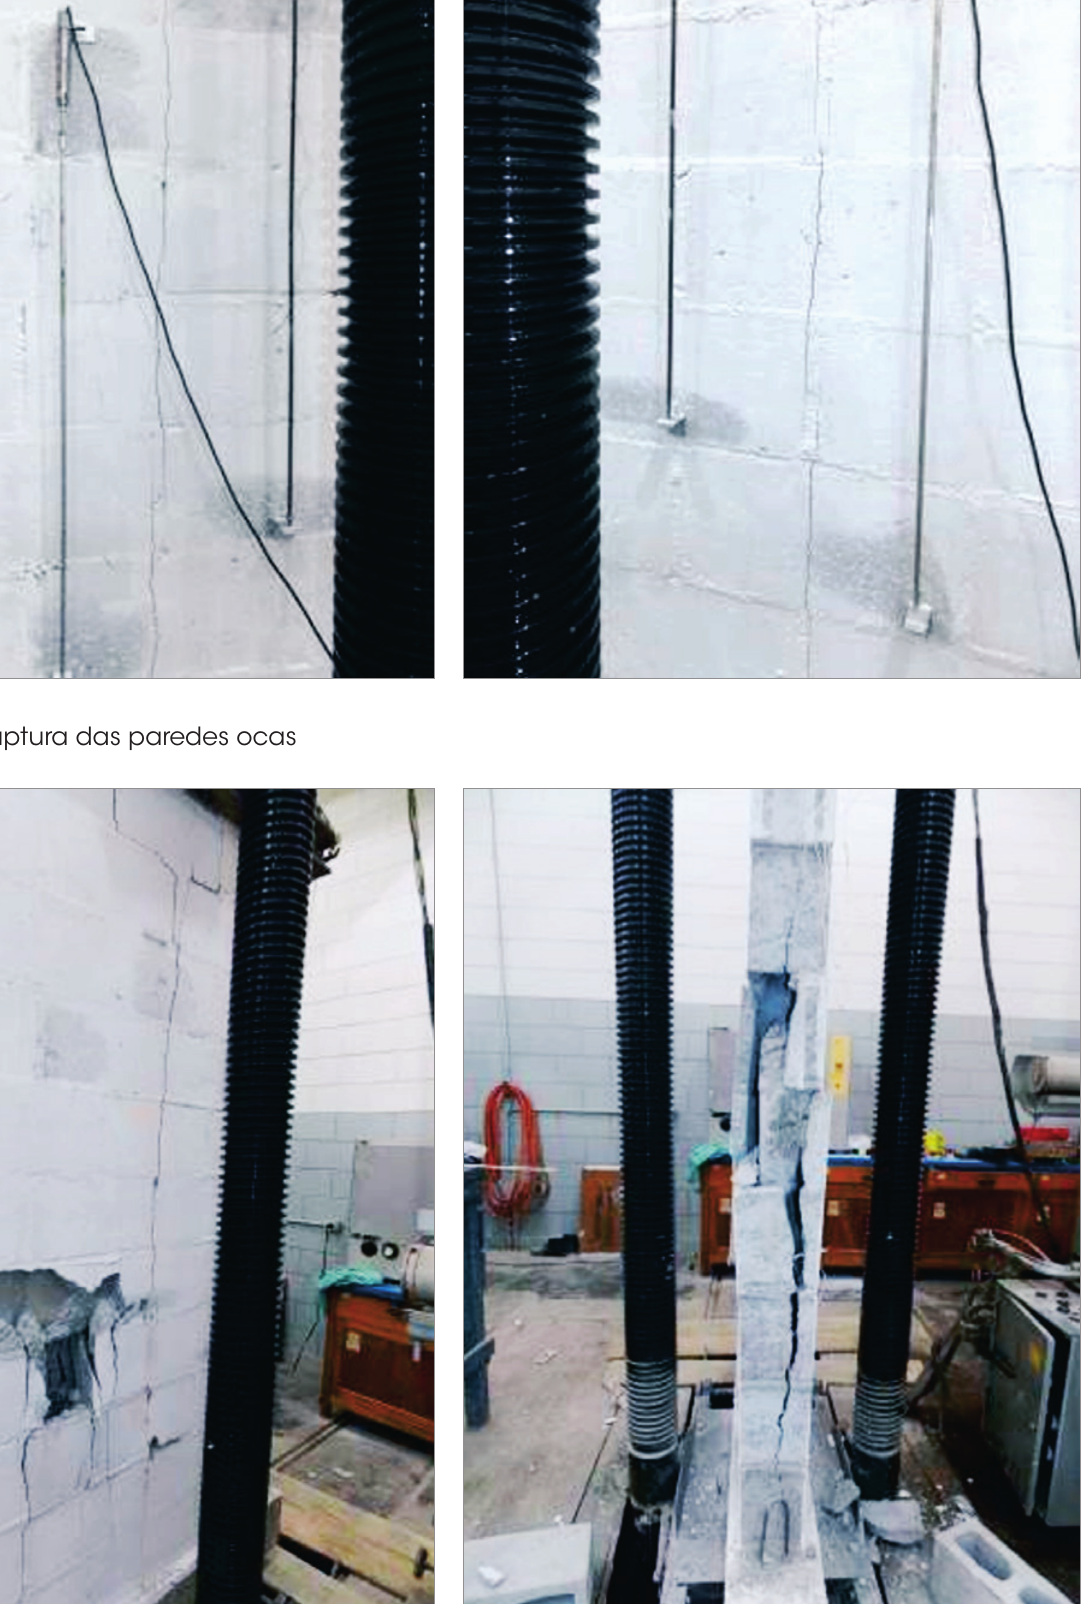
Ilustração da ruptura com fissuração vertical e esmagamento da alvenaria